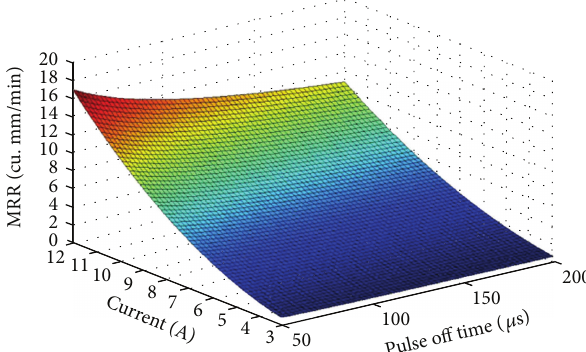
Figure 3: Effect of pulse off time and current on material removal rate (MRR) at pulse on time = 125 𝜇 s.